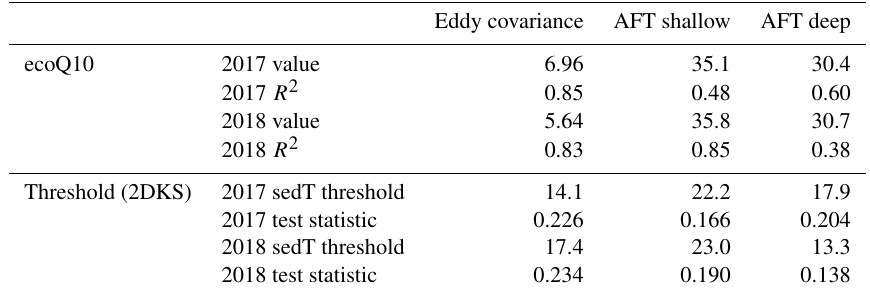
and sediment temperature per the ecoQ10 analysis and the two- 4